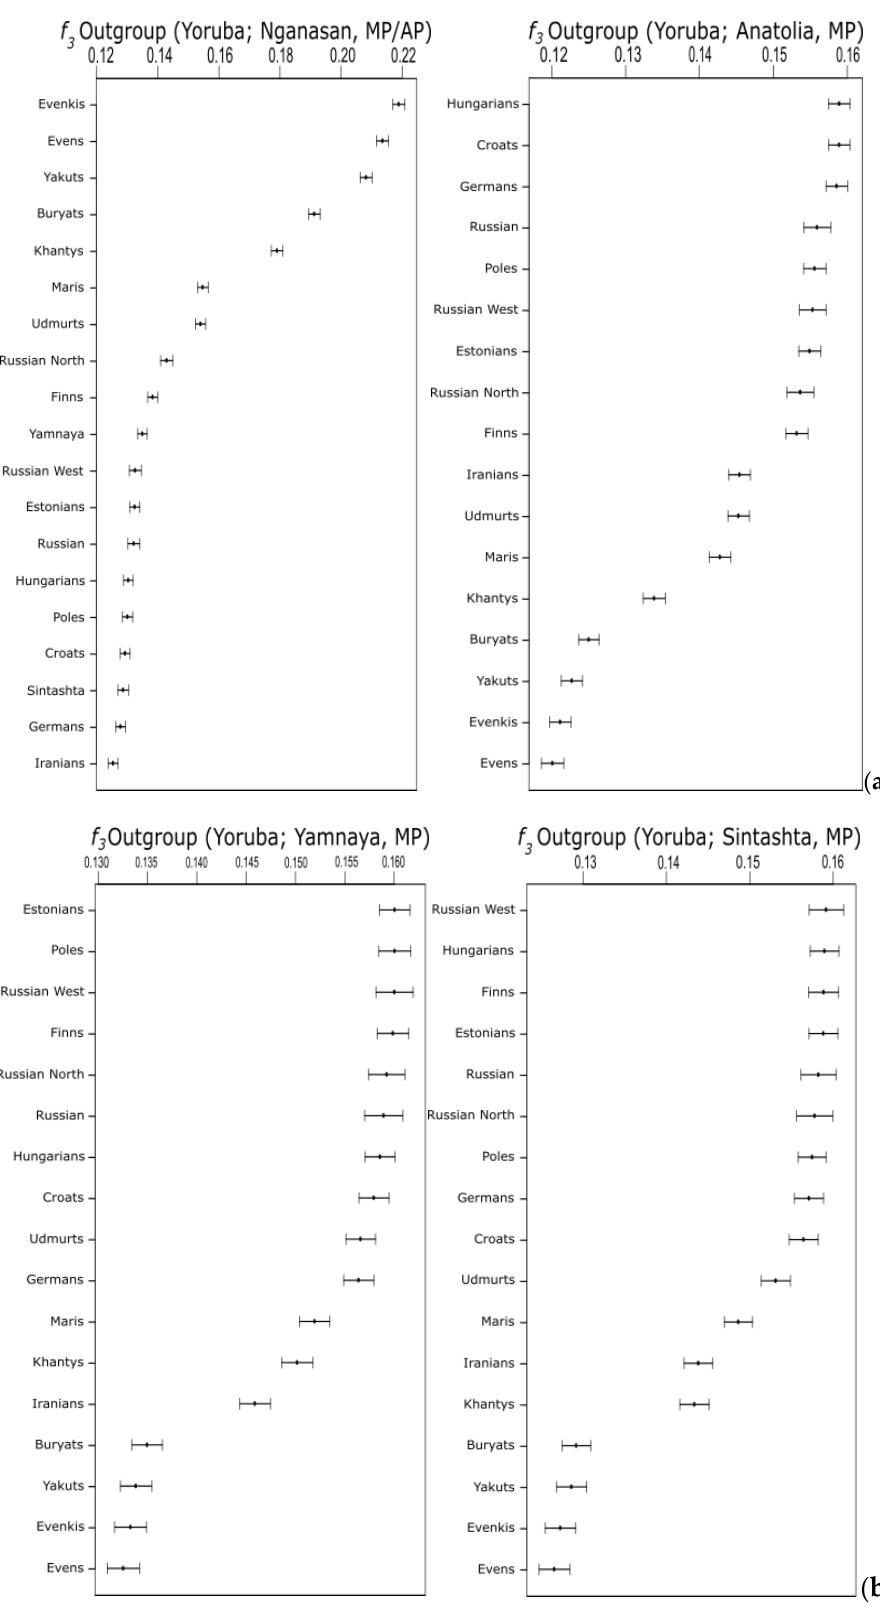
Figure 6. Outgroup f3 -statistic analysis. Shared genetic drift between ancient and modern (MP) populations. ( a ) Shared genetic drift between Anatolian, Yamnaya, Sintashta, ( b ) Nganasan and modern/ancient populations.